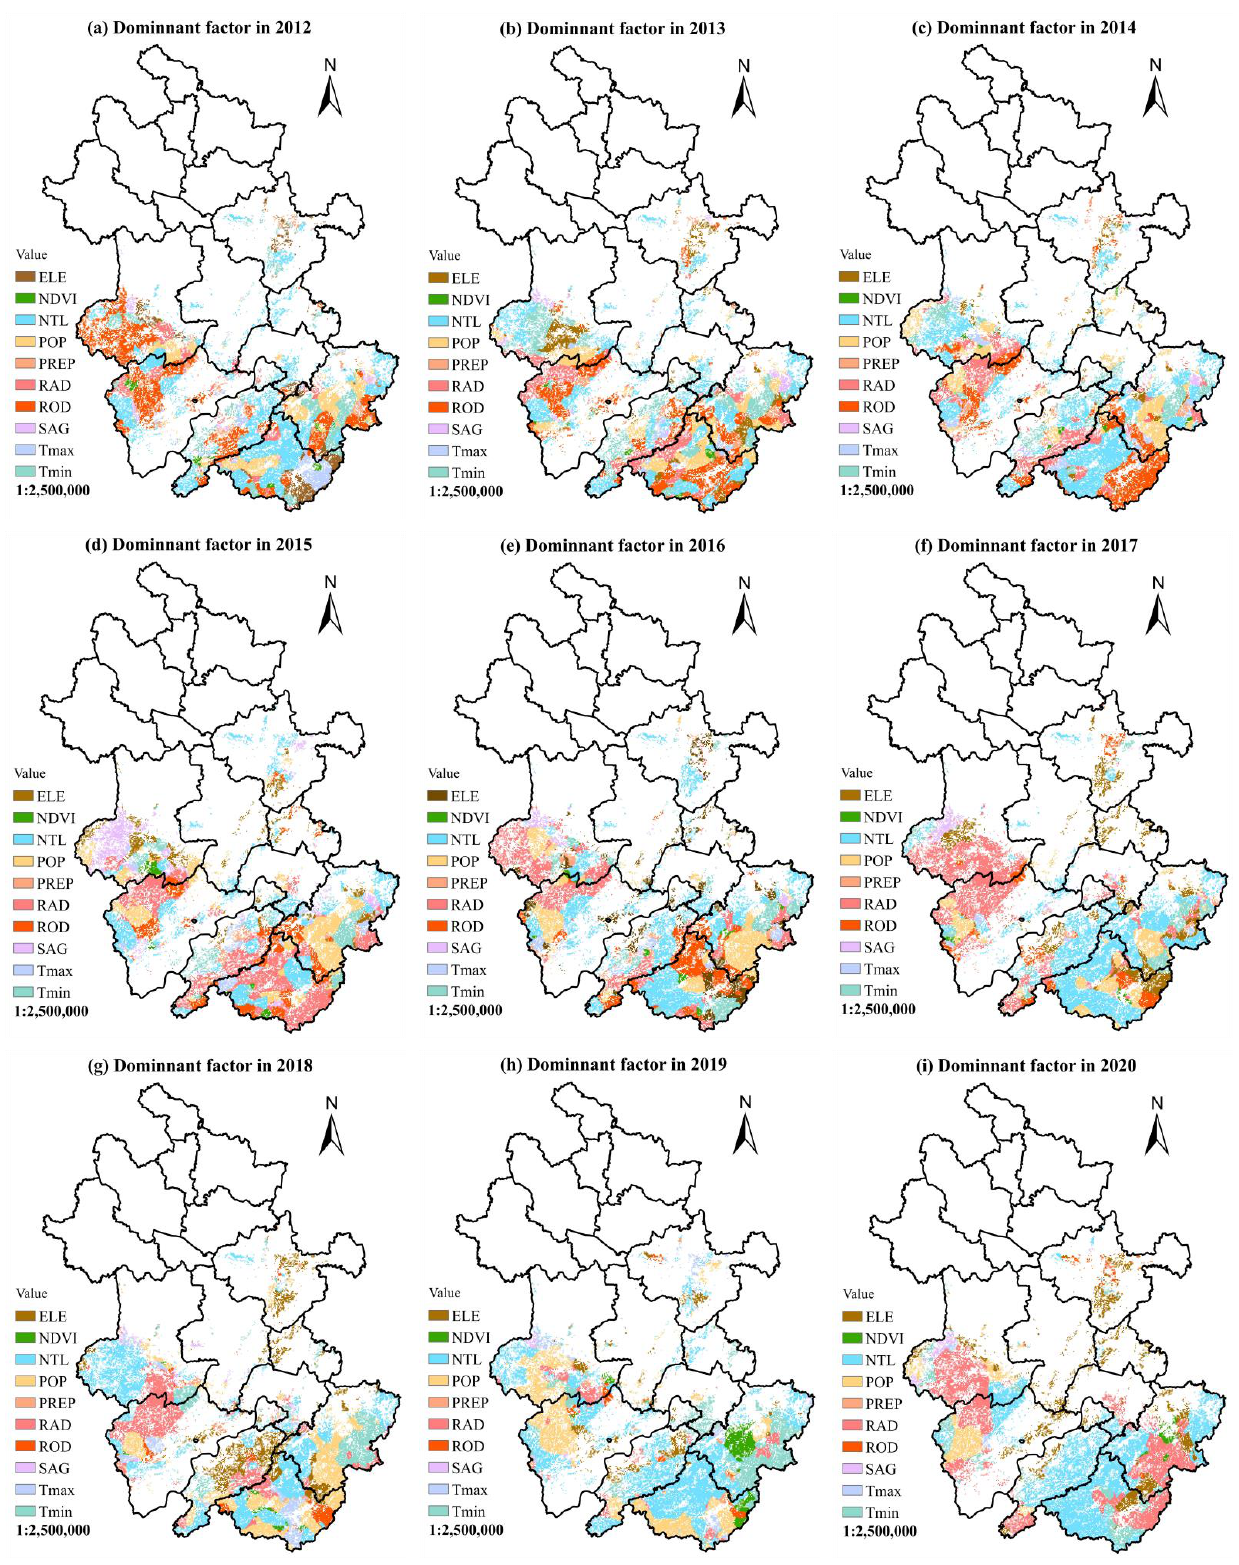
Figure 20. Spatial distribution of dominant factors from 2012 to2020.